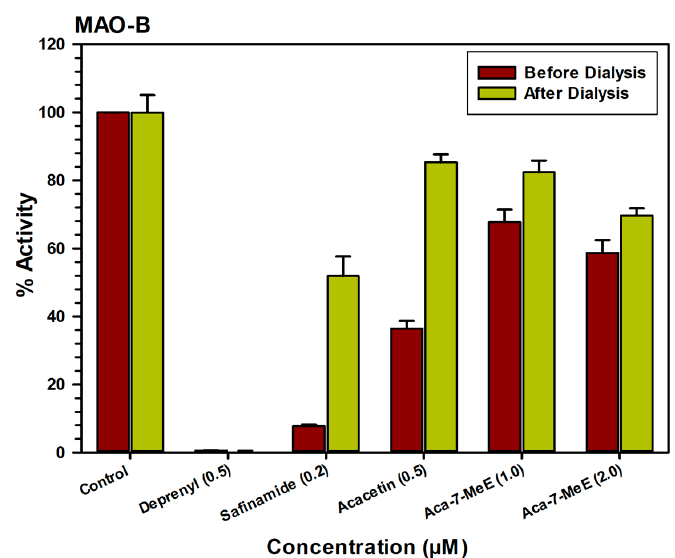
Figure 4. Reversibility assay of recombinant human MAO-B with acacetin (0.5 μ M), acacetin 7-methyl ether (Aca 7-MeE) (1.0 and 2.0 μ M), deprenyl (0.5 μ M), and safinamide (0.2 μ M). The remaining activity was expressed as % of activity. Each point shows the mean ± S.D. value of three observations.